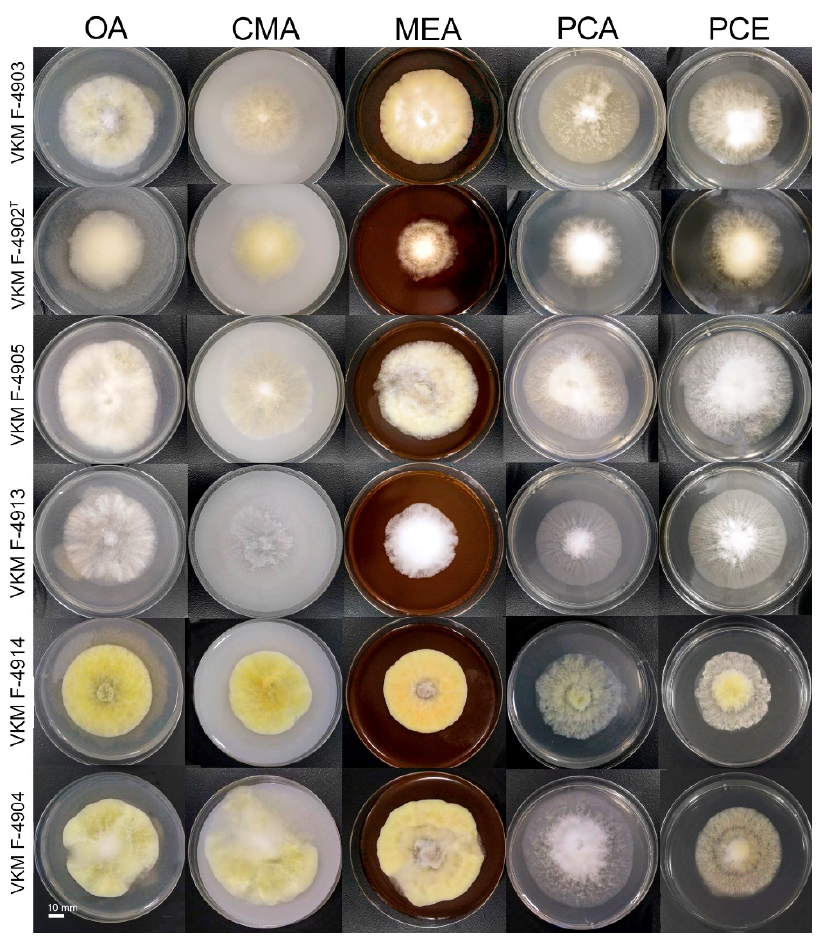
Figure 4. Trichocladium solani sp. nov. on different media. OA—oatmeal agar; CMA—cornmeal agar; MEA—malt extract agar; PCA—potato carrot agar; PCE—potato carrot extract. Cultures were incubated for 7 days at 25 °C.